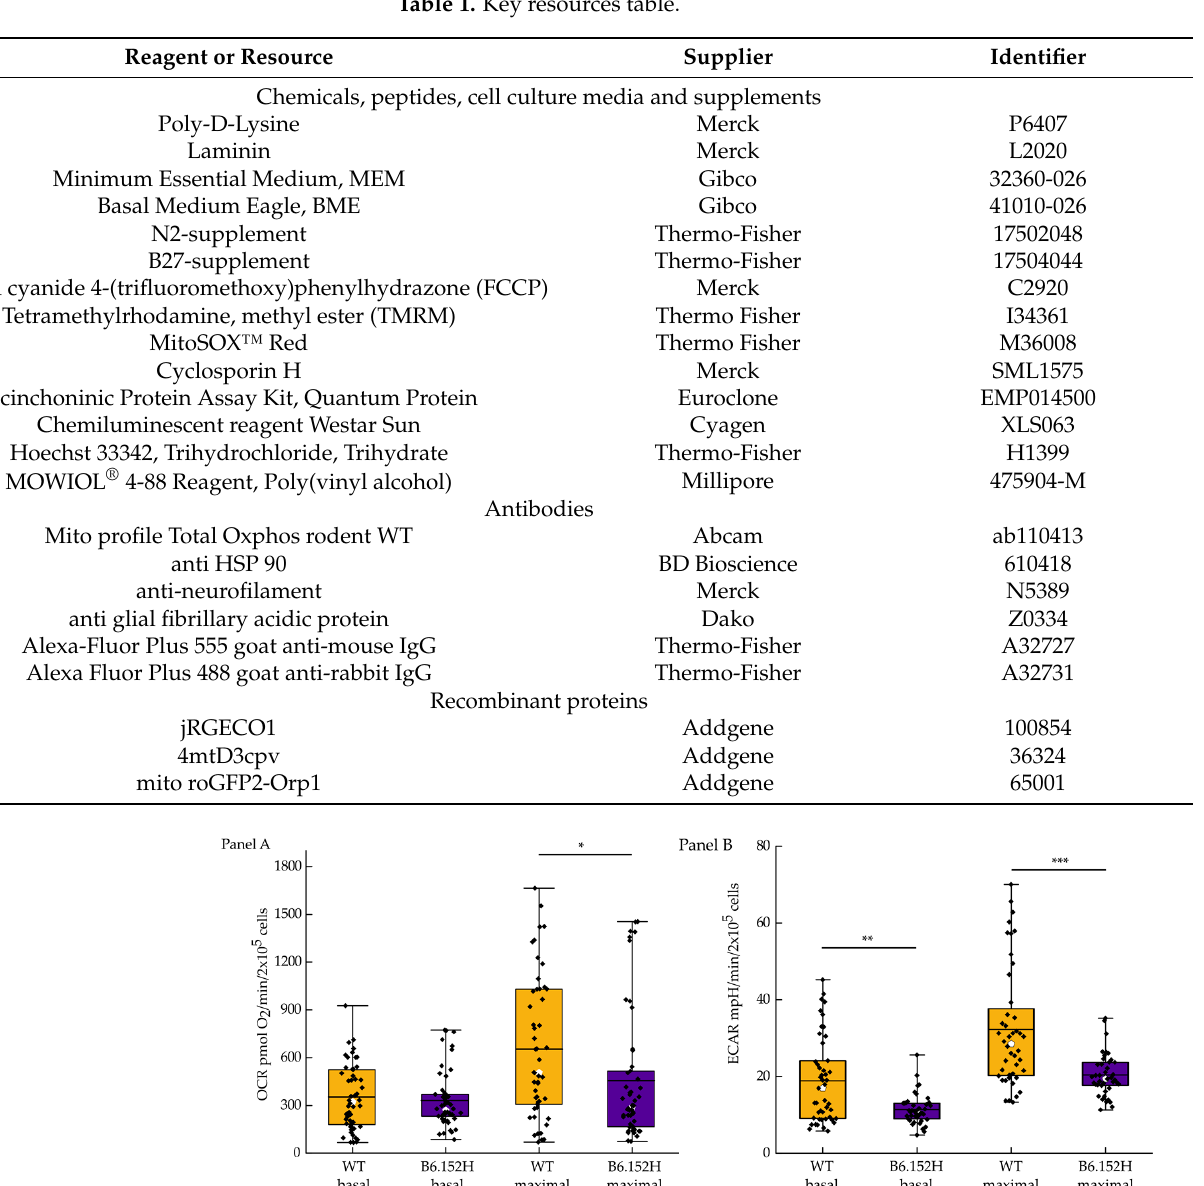
Figure 1. Quantification of intact-cell respiratory rate, OCR, and of the extracellular acidification rate ECAR. Panel ( A ), Basal OCR, (expressed as pmols of O 2 consumed per minute per 2 × 10 5 cells/well) combination of ATP synthesis-driven respiration plus the respiration caused by the leak of protons from the membrane (WT n = 50 wells, mean ranks = 57.88; B6.152H n = 50 wells mean ranks = 43.12; Mann–Whitney probability test Asymp. prob = 0.8); at the 0.05 level, the two distributions are not significantly different. Maximal OCR (uncoupled respiration), (WT n = 50 wells, mean ranks = 51.2; B6.152H n = 50 wells, mean ranks = 49.8; Mann Whitney probability test Asymp. prob = 0.011, at